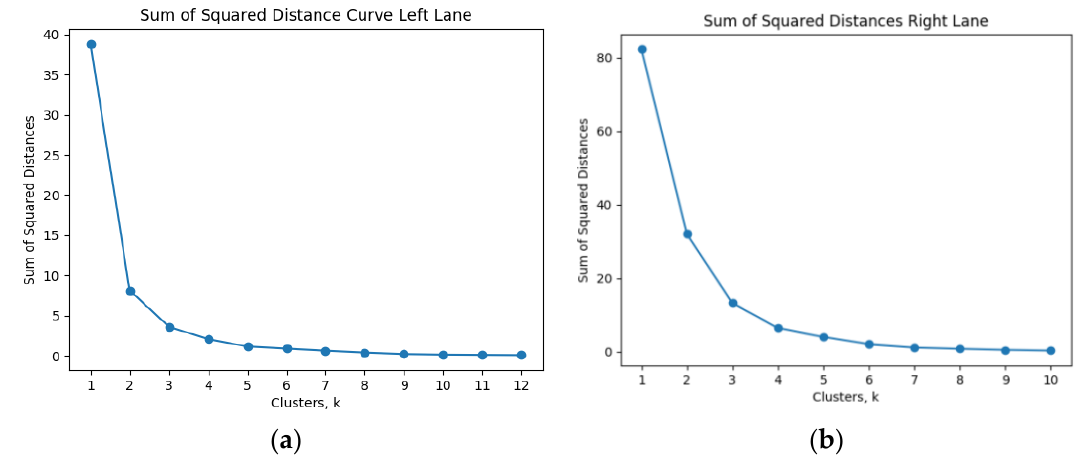
Figure 11. Sum of Squared Distances over k clusters for the ( a ) the left and ( b ) right lane. As the k -Means algorithm does not give distinct values for the incident category, the square deviation between the incident category (1, 2, 3, 4) and the cluster centroids given by the algorithm was calculated. For the category of incidents, a rounding was performed based on the result given by the cluster rounding to the nearest integer. The function that rounds the centroids is given by Equation (12).